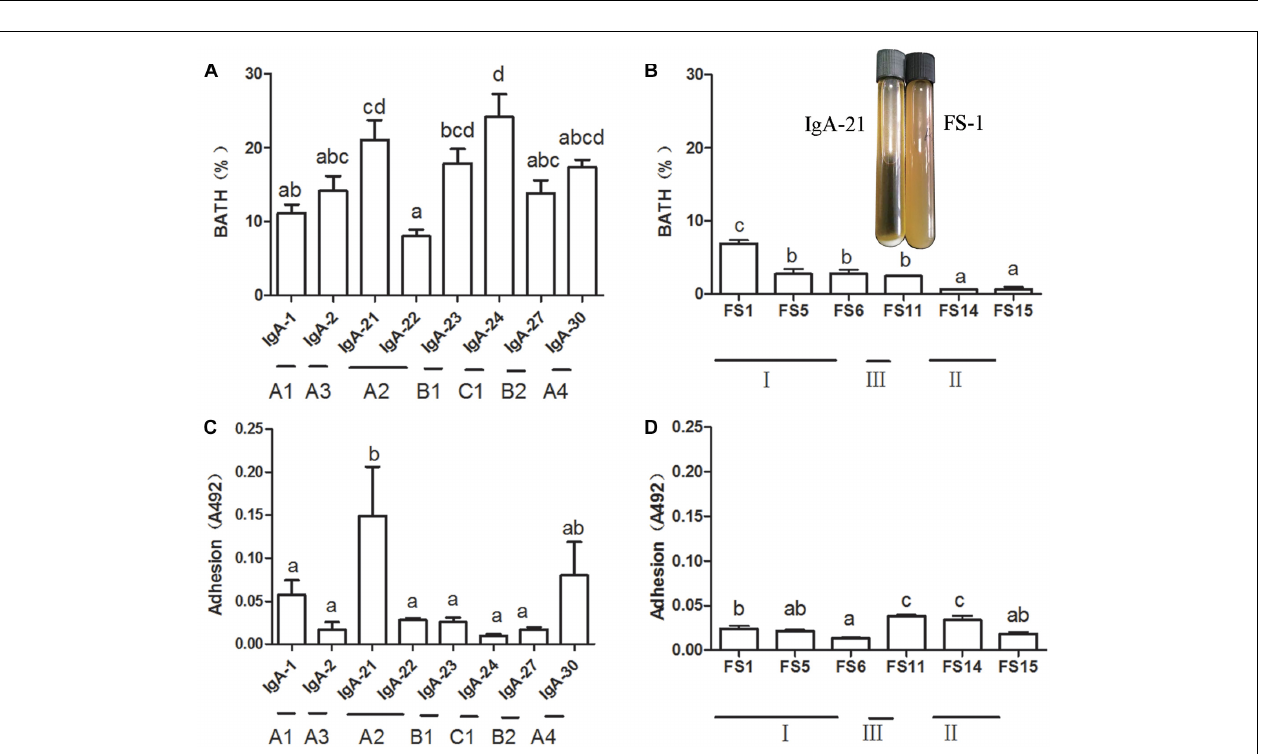
FIGURE 2 | Mucus adhesion and cell surface hydrophobicity of Lactobacillus jensenii of different amplified fragment length polymorphism (AFLP) patterns (A,C) and Pediococcus acidilactici FS1 (B,D) and growth state in liquid medium of L. jensenii IgA-21 and P. acidilactici FS-1. Data are presented as mean ± SD ( n = 6). Columns with different letters represent significant difference at P < 0.05 between different strains. Comparisons were made with one-way ANOVA followed by Tukey’s multicomparison test. BATH: bacterial adhesion to hydrocarbon.